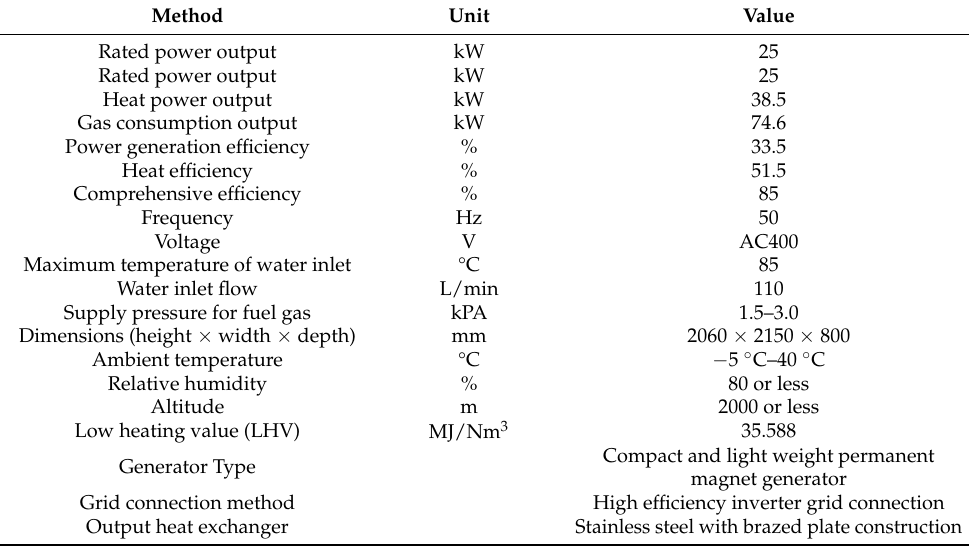
Figure 1. The CHP system flow chart. Table 2. The parameters of the internal combustion